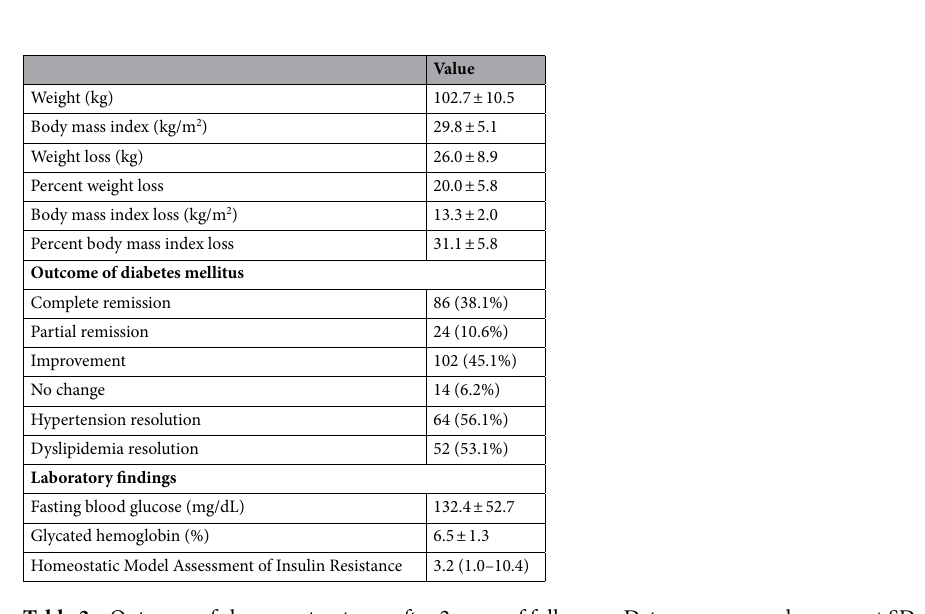
Table 3. Outcome of sleeve gastrectomy after 2 years of follow up. Data are expressed as mean ± SD, median (range), or number